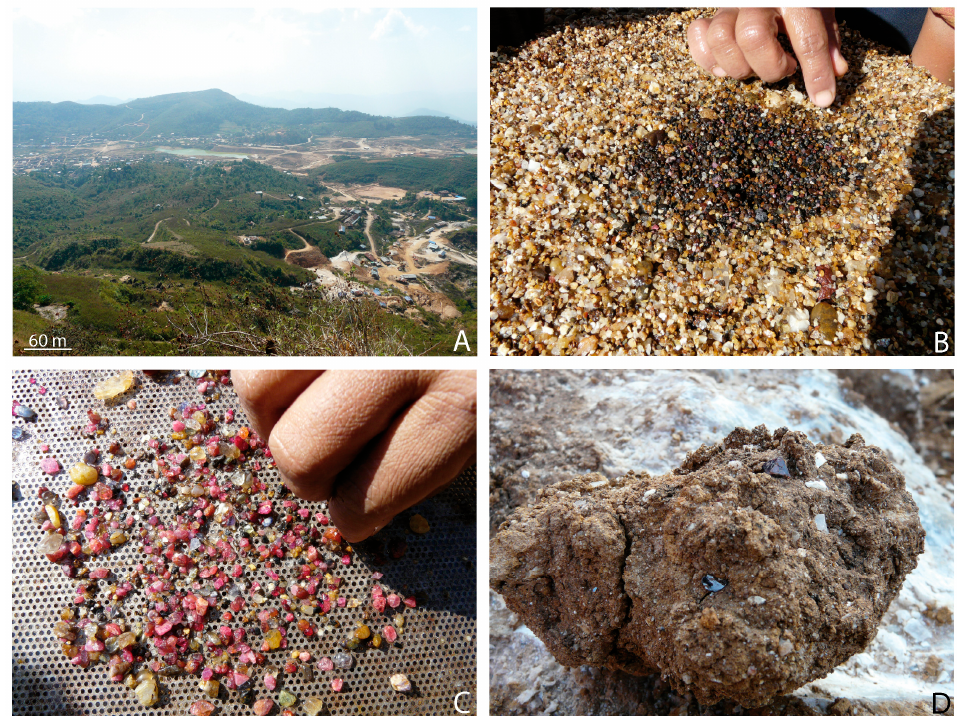
Figure 56. Different aspects of the gem placers in the Mogok Stone Track, Myanmar (in January 2015). ( A ) Panoramic view of the primary deposits mined in marble on the flank of the hills (foreground view) and secondary deposits, i.e., placers, mined in the valley (background); ( B ) image of the gem-bearing material called ‘byon’ enriched in gravels and sand. The concentration of heavy minerals is visible and is composed of iron oxides, corundum, quartz, and pieces of marble; ( C ) concentration of gem minerals (ruby, spinel, and sapphire) in the pan of a miner; and ( D ) sedimentary breccia formed in a cave placer karst. The breccia formed from an argillite containing crystals of spinel, plates of graphite, and fragments of marble and quartz. Size of the breccia sample around 15 cm long. Photo: Gaston Giuliani. Similar deposits are found at Namya in the northern part of the country where the monsoon is an effective erosion mechanism in low-altitude environments [5,108,261]. The gem concentration is closely related to the formation of karst and chemical weathering of marble and associated rocks, i.e., schists, gneisses, and granitoids (Figure 56D). The cave placers in karst contain sedimentary breccias